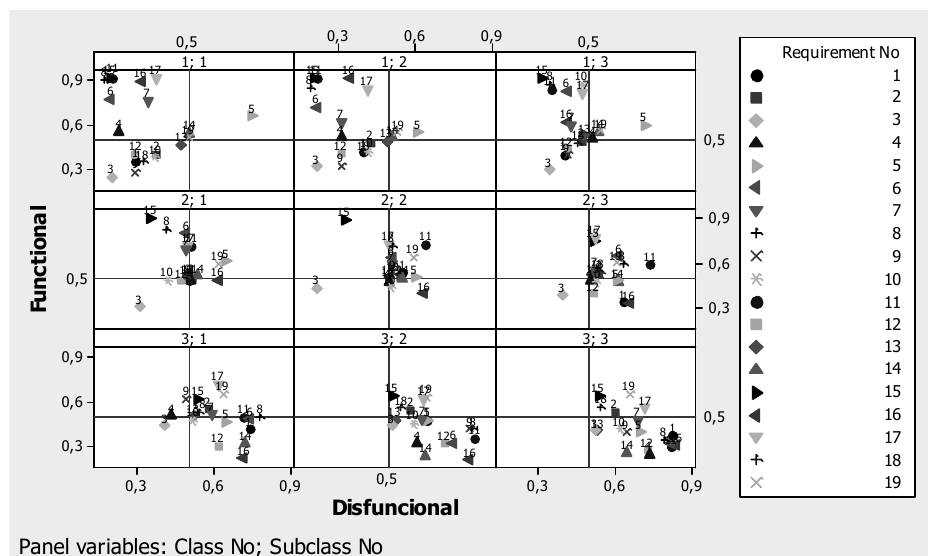
Figure 3 – Scatter plot of Functional vs